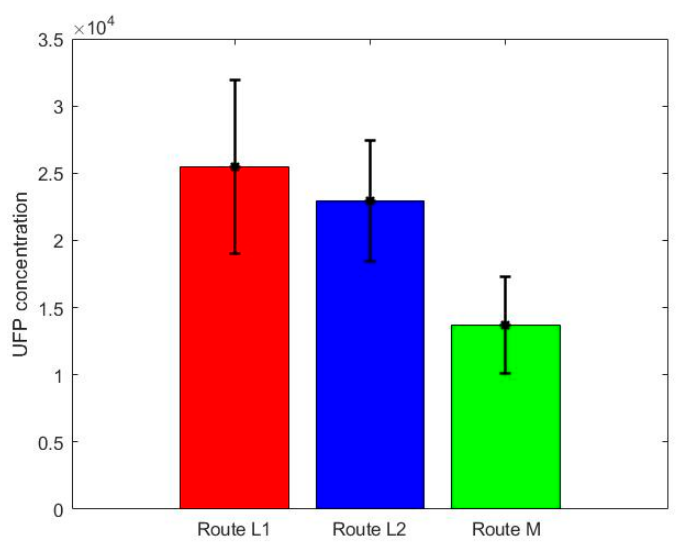
Figure 6. Bar plot of daily exposure for each route (the error bars are the standard error of the means).